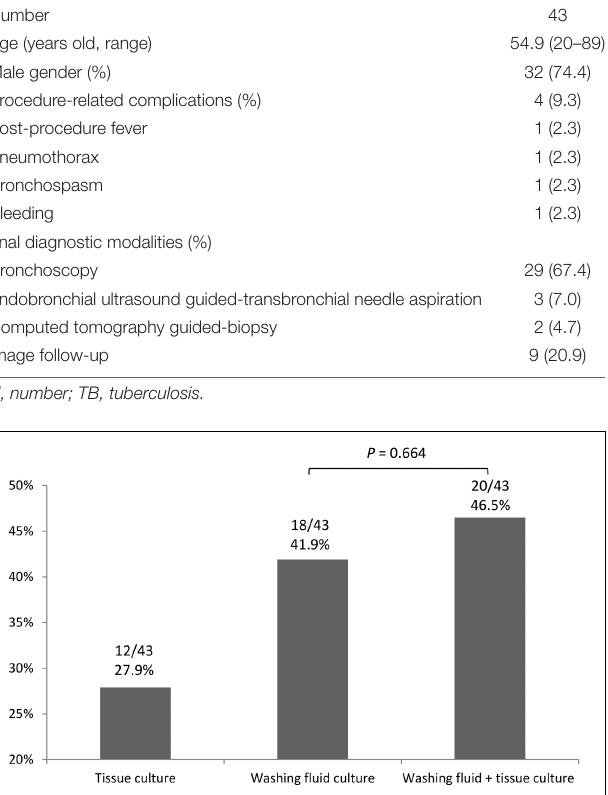
FIGURE 1 | The positive TB culture rate of washing fluid and tissue specimen via EBUS–TBB. EBUS–TBB, endobronchial ultrasound-guided transbronchial biopsy; TB,